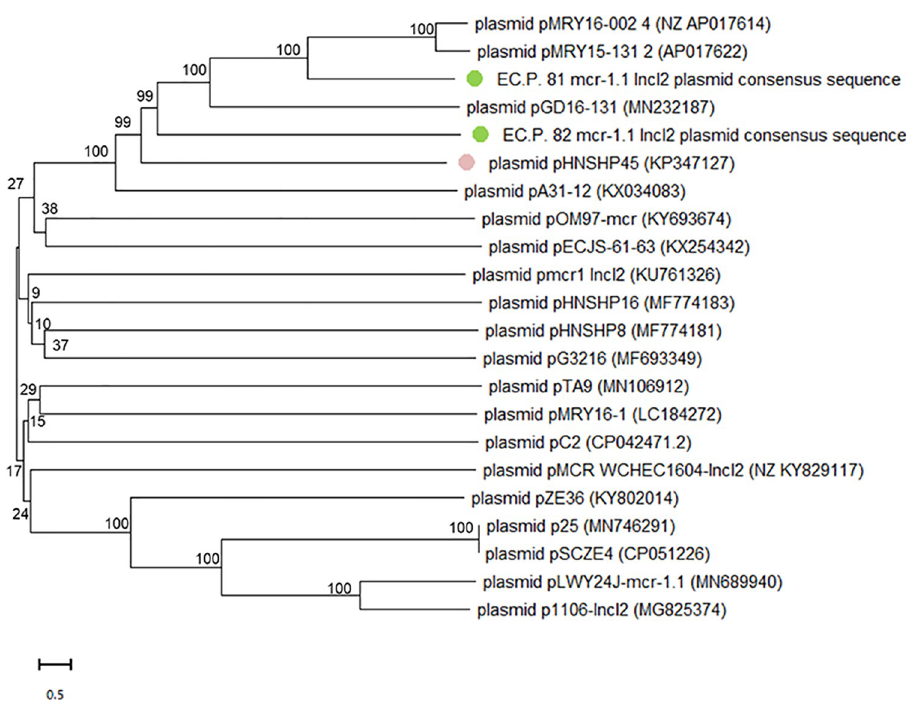
Fig 1. Phylogenetic analysis of the mcr-1 . 1 -carrying IncI2 plasmids. Phylogenetic analysis of the mcr-1 . 1 -carrying IncI2 plasmids in ECP.81 and ECP.82 from sick pigs (green dot) and other mcr-1 -carrying IncI2 plasmids from E . coli deposited in the GenBank database. Sequences were aligned using MUSCLE and phylogenetic interferences were obtained using the neighbor-joining method within the MEGA 10 software. Numbers at the nodes are percentages of bootstrap values obtained by repeating the analysis for 1000 times to generate a majority consensus